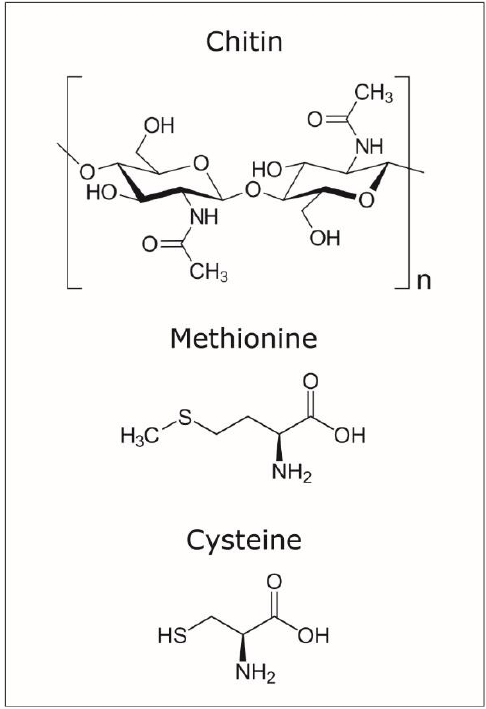
Figure 5. Molecular configuration of chitin, methionine, and cysteine.